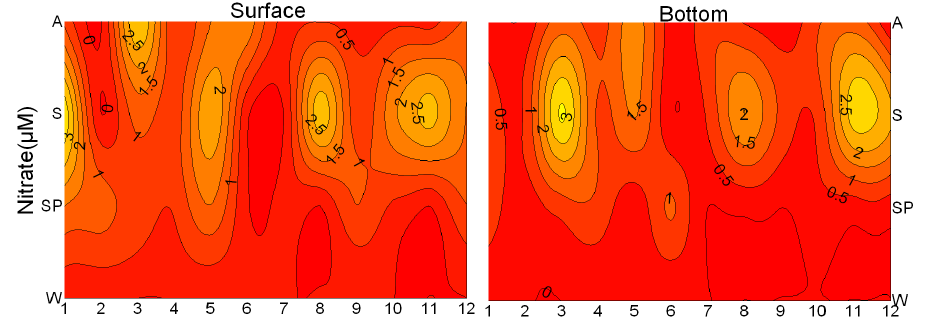
Figure 3. Changes of the nutrient concentration and Chl- a at surface and